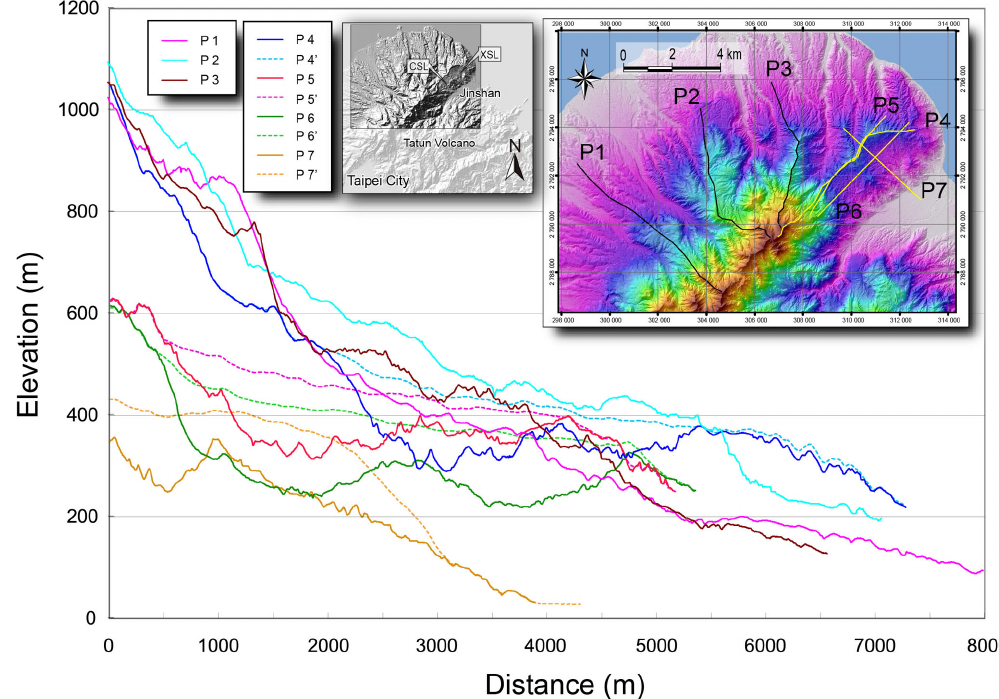
Figure 8. Topographic profiles of the Tatun volcanic cone. For P4, P5, and P6, profiles from the original (solid line) and the reconstructed (dashed line) DTMs are shown. The profile locations are shown in the inset in the upper right corner. The original ground surface is extracted from the lidar